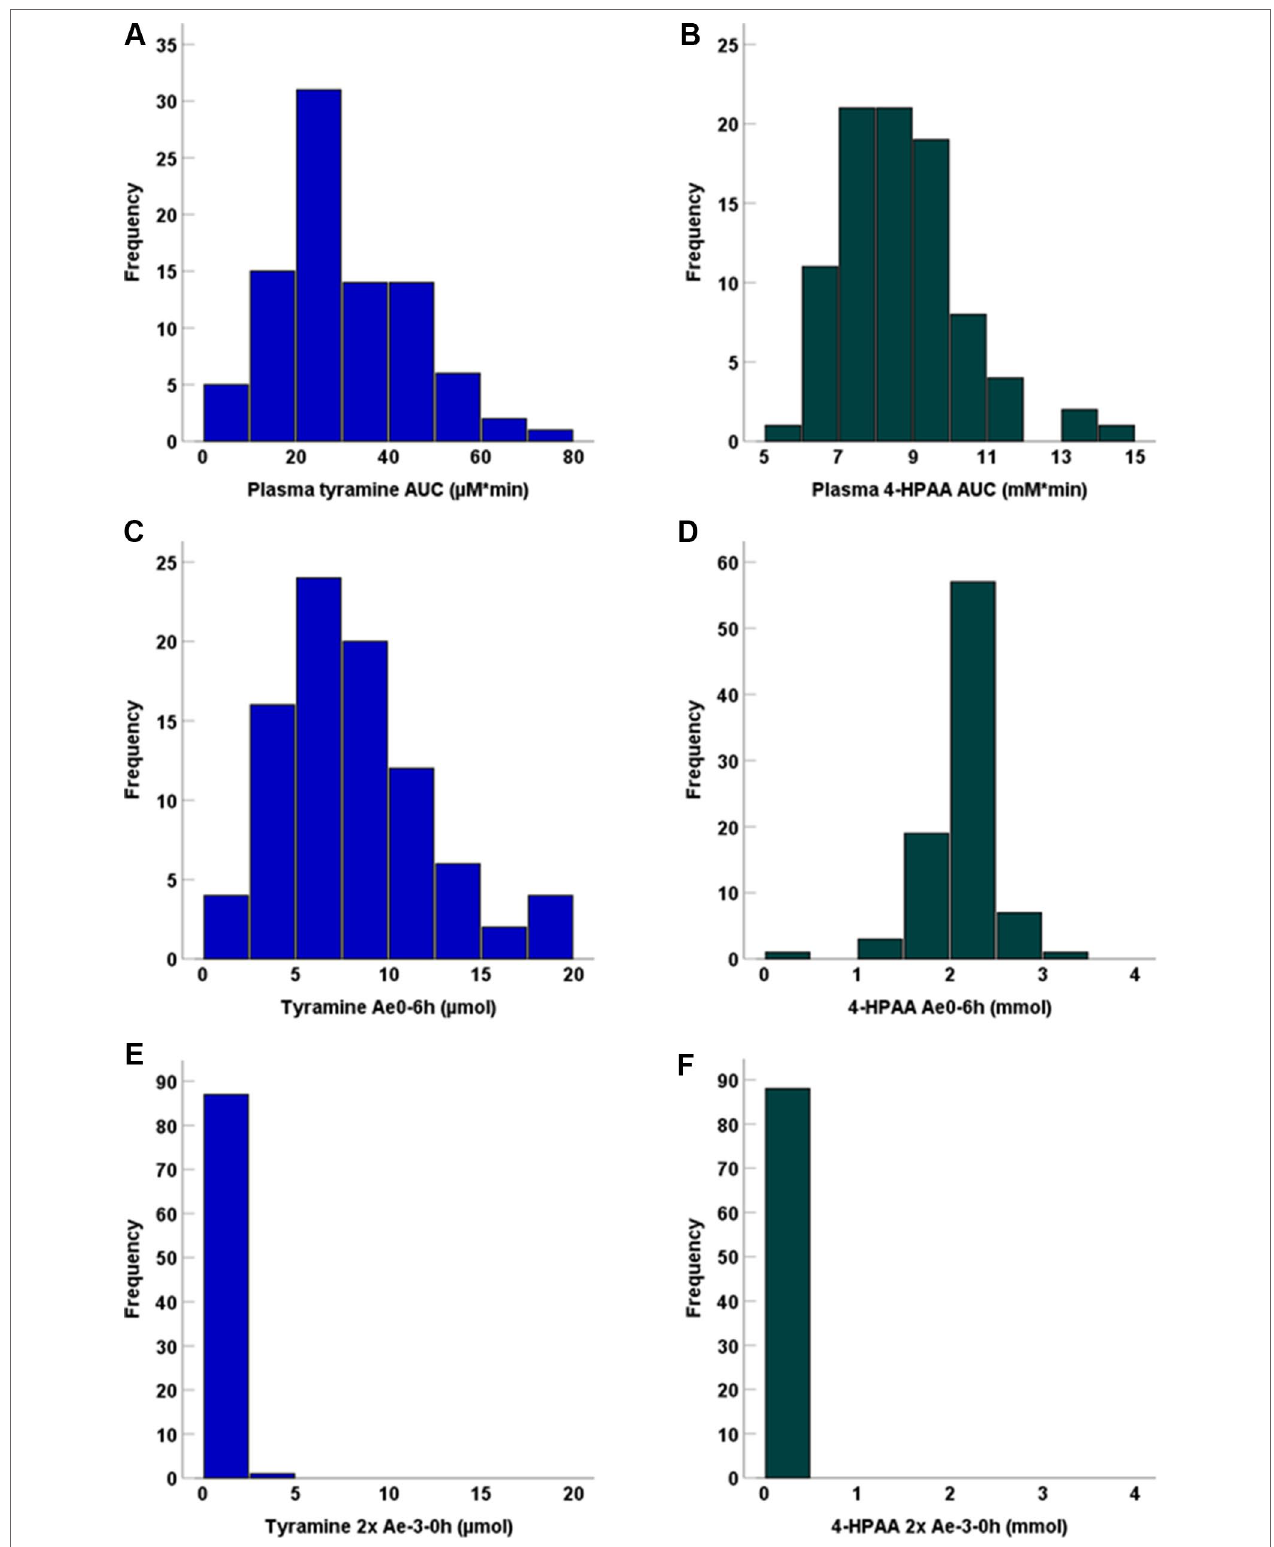
FigUre 3 | Frequency distribution of plasma AUCs for (A) tyramine and (B) 4-HPAA, as well as (C) tyramine Ae 0-6h , (D) 4-HPAA Ae 0-6h , (e) tyramine Ae -3-0h , and (F) 4-HPAA Ae -3-0h . Baseline Ae (Ae -3-0h ) data were multiplied by 2 for better comparison to the 6h post-application measurement interval.